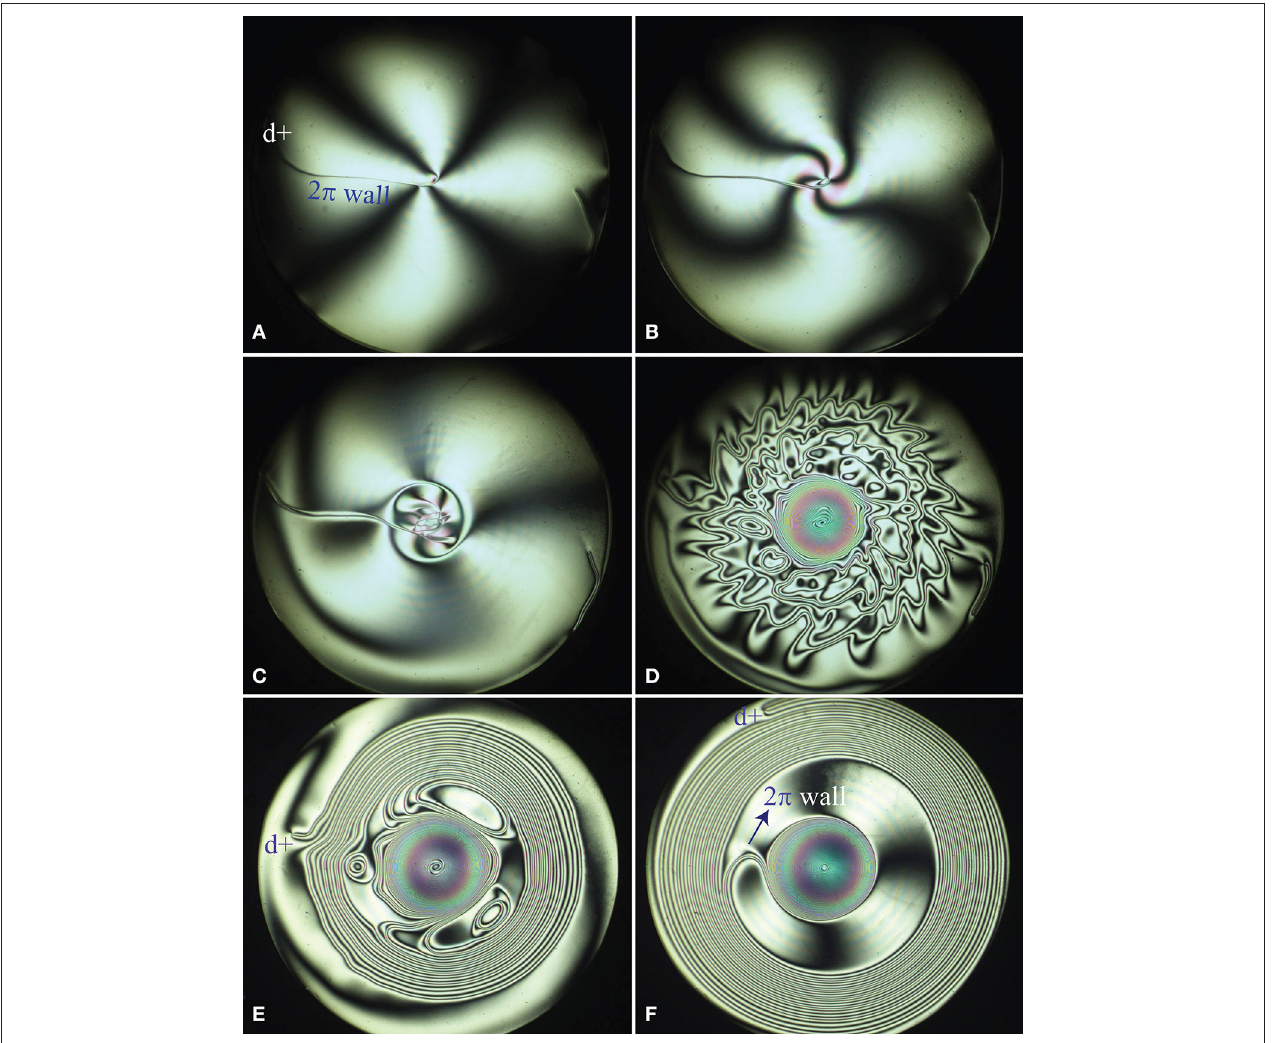
FIGURE 10 | Generation of the second Cladis-Brand dynamically stable state by the phase winding in the Circular Dowsons’ Collider. (A) At the beginning of the winding, the “residual” d + dowson is close to the edge of the droplet. It is connected to the center O by a 2 π wall. (B–D) Upon application of a strong excitation, the phase is wound up simultaneously in clockwise direction for r < rc and anticlockwise direction for r > rc . (E,F) Emergence of the second Cladis-Brand dynamically stable state with the dowson d + orbiting around an extended double target pattern. The outer and inner target patterns are made of one spiral-shaped 2 π wall connecting the dowson d + with the center of the